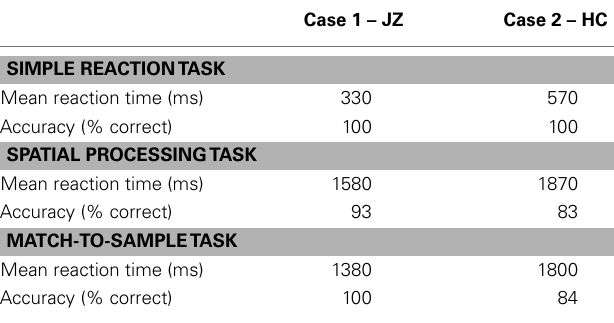
Table 2 | Performance on computerized assessments during fMRI